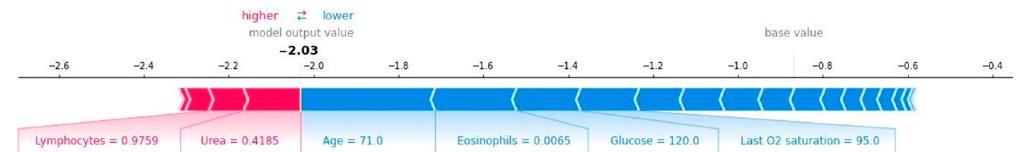
Figure 10. Example of a graphical representation of the Shapley values provided by the tool. Base value : mean prediction of the test set. Blue variables contribute to decreasing the probability of the patient risk, whereas red variables contribute to increasing the probability of patient risk. The magnitude of such increase or decrease is measured by the length of the